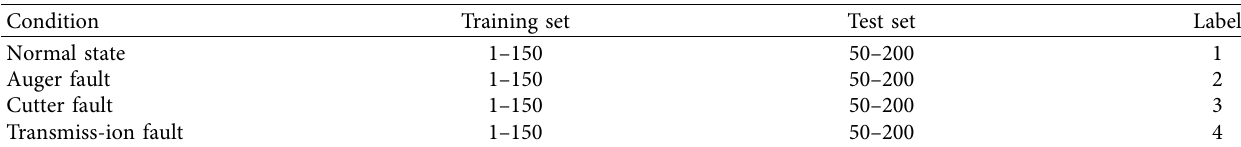
Figure 5: Waveform diagram of cutter fault signal. (a) Time-domain diagram of cutter fault signal. (b) Frequency-domain diagram of cutter fault signal. Table 3: Data set presentation.